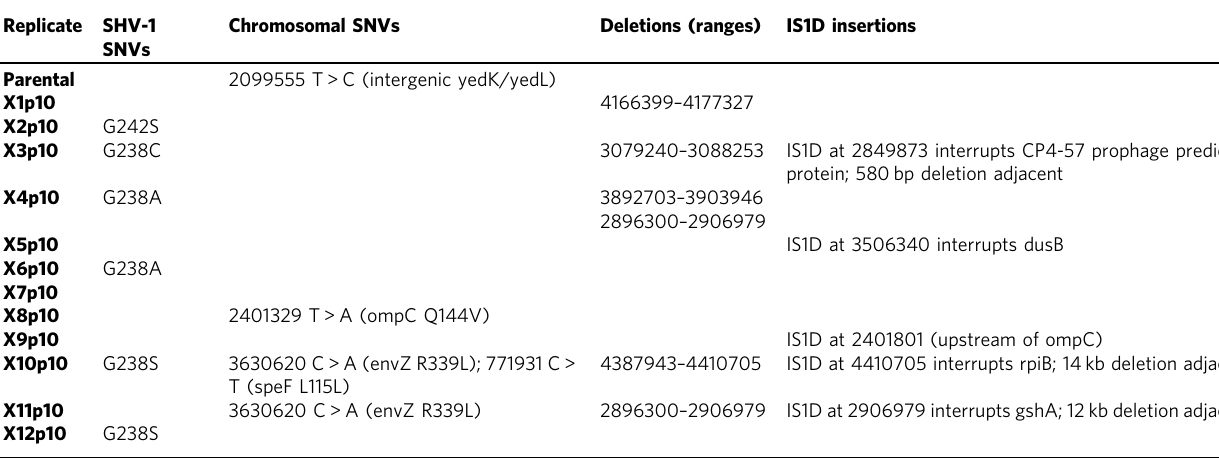
Table 2 Mutations identi fi ed through whole-genome sequencing Replicate SHV-1 Chromosomal SNVs Deletions SNVs